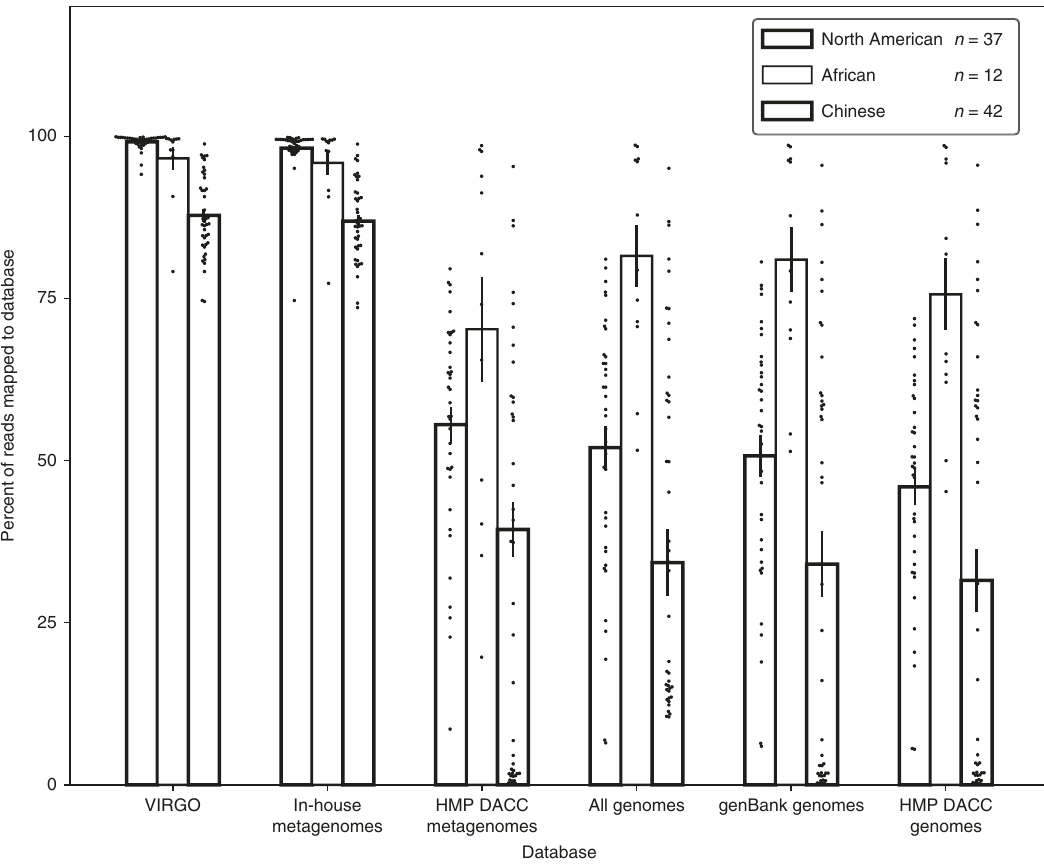
Fig. 1 Percent of vaginal metagenome reads that can be mapped to contigs from the following reference data sets. Complete VIRGO database, 211 in- house sequenced vaginal metagenomes, 53 HMP DACC vaginal metagenomes 24 , all HMP urogenital reference genomes, 277 genomes of bacteria isolated from vagina, reproductive or urinary system deposited in GenBank, and 139 genomes of urogenital bacteria from HMP DACC database 11 . Values plotted are the average, error bars represent the standard error of the